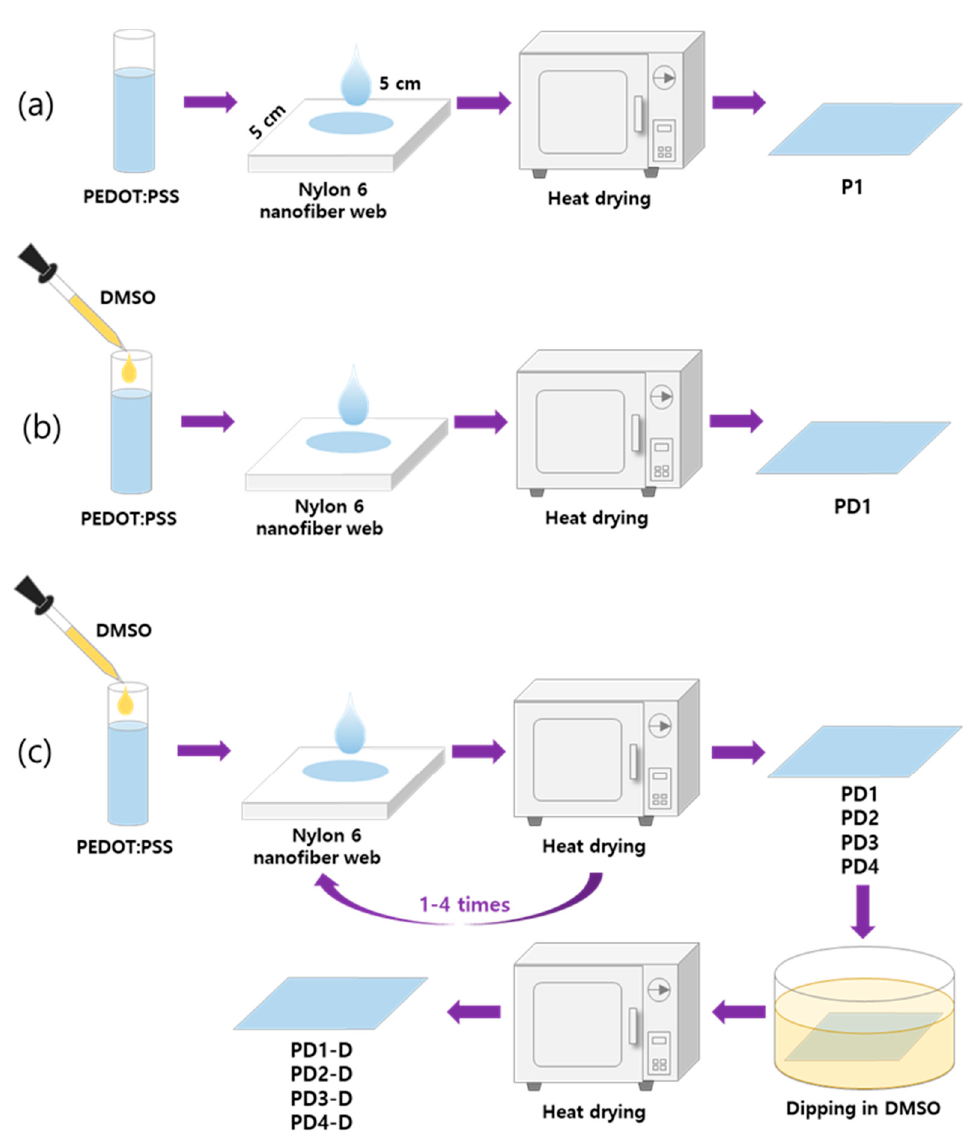
Figure 1. Schematic diagram of the sample fabrication process where ( a ) is treated with pristine PEDOT:PSS only, ( b ) is treated with PEDOT:PSS added with DMSO, ( c ) is repeatedly coated with DMSO-treated PEDOT:PSS and then immersed with DMSO.